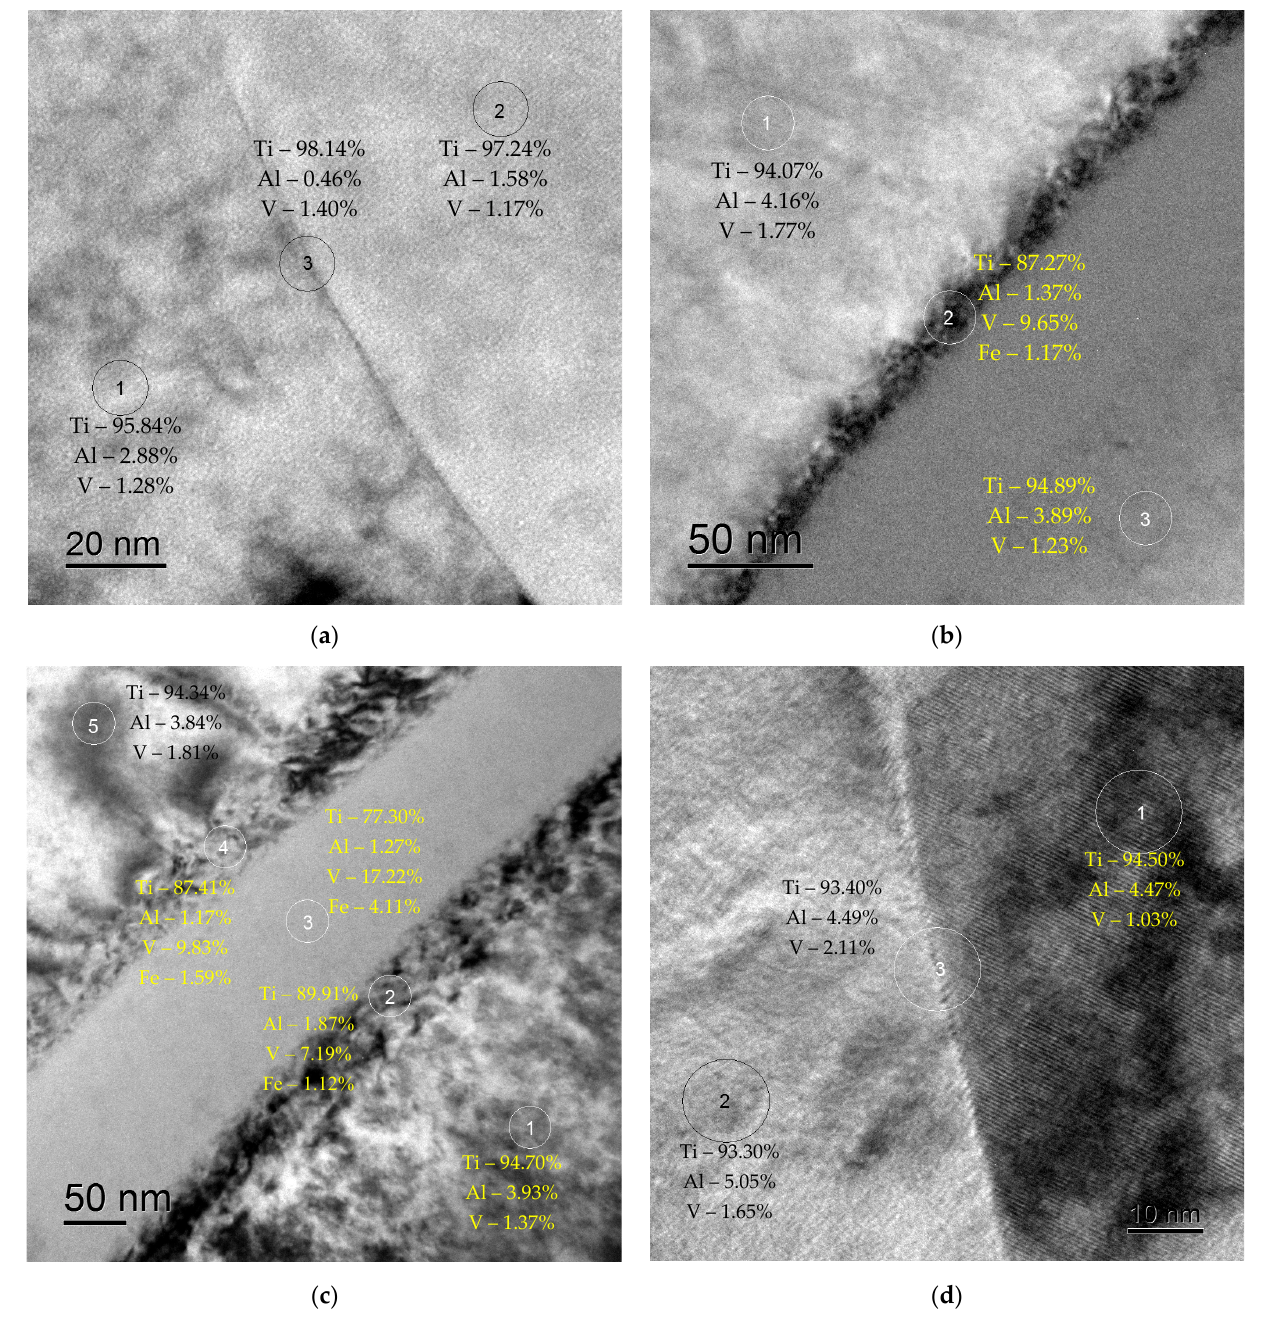
Figure 4. EDS microanalysis of the grain boundary composition in the coarse-grained ( a – c ) and UFG ( d ) alloy Ti-5Al-2V, reprinted with permission from [26,50]. ( a ) GB of type I; ( b ) GB of type II; ( c ) β -particle in the GB of type II; ( d ) GB in the UFG alloy. TEM.